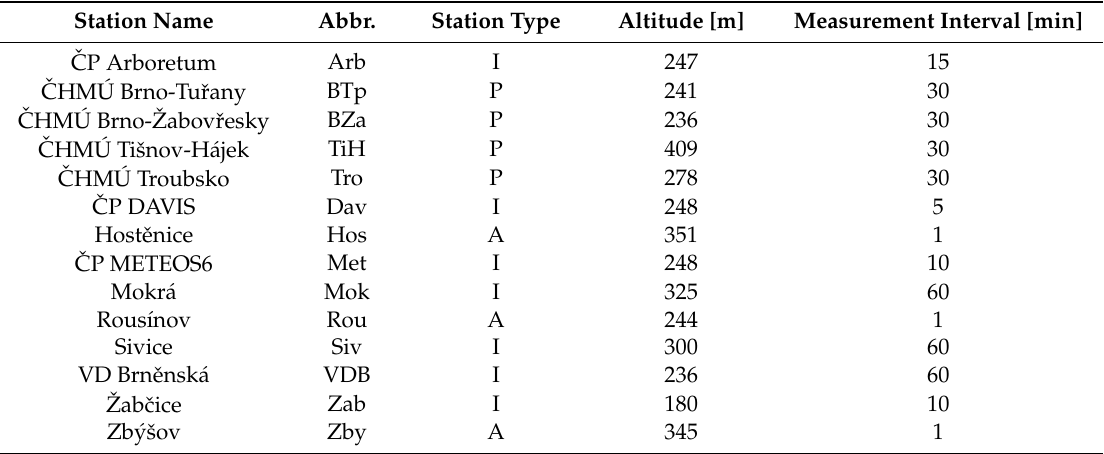
Table 1. List of used stations and their characteristics (station type: A—amateur, I—institutional,